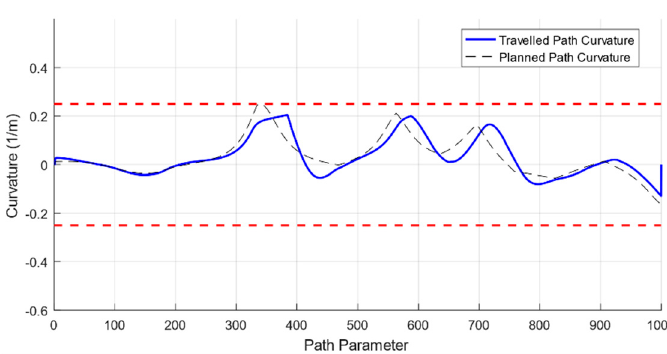
Figure 15. Curvature analysis of the planned and traveled paths.